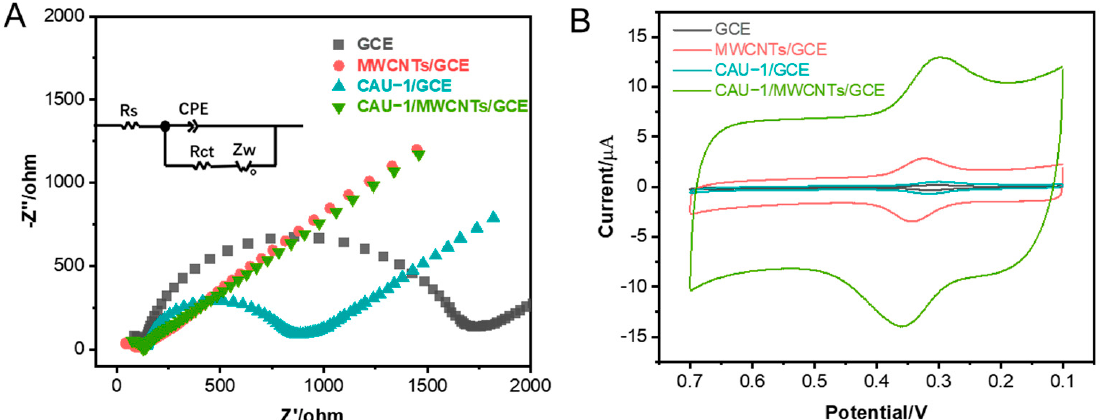
Figure 2. ( A ) EIS spectra of different electrode materials, supporting electrolyte solution: 1 mM Fe(CN) 63 − / 4 − (containing 0.1 M KCl) (inset: equivalent circuit diagram); ( B ) electrochemical responses of different electrode materials to 2 μ M rutin at pH = 5.5.